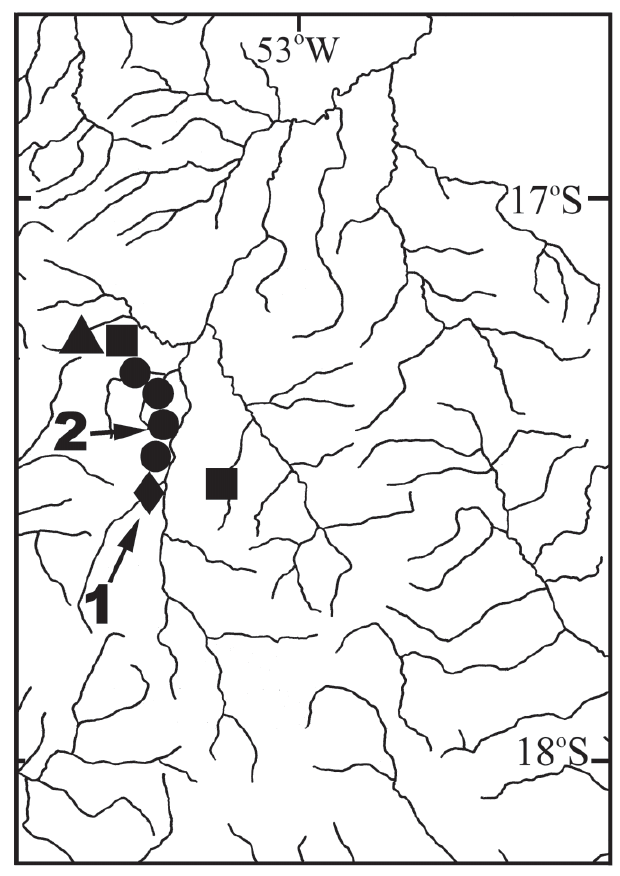
Fig. 5. Upper rio Araguaia basin, showing sites of occurrence of Hyphessobrycon langeanii , H. eilyos , and H. weitzmanorum (diamonds), H. langeanii and H. weitzmanorum (dots), H. langeanii and H. eilyos (triangle), or H. langeanii (squares). 1. Ribeirão do Sapo, type locality of H. eilyos . 2. Córrego Mosquito, type locality of H. langeanii and H. weitzmanorum